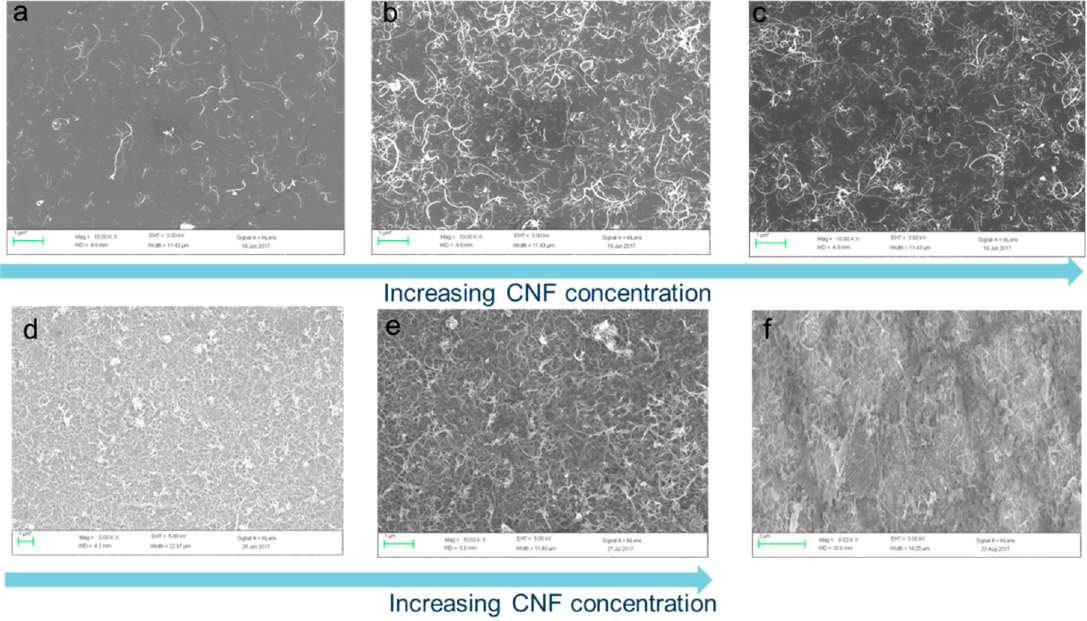
Figure 4. SEM images of carbon nanofibers (CNFs) deposited with the spray technique. The coverage rate increases until full coverage is reached in Figure 5e (single nozzle) and 5f (double nozzle). The concentration of the CNFs is increased due to the deposition time ( a ) 3 µ m − 1 ( b ) 6 µ m − 1 ( c ) 10 µ m − 1 ( d ) 15 µ m − 1 ( e ) 30 µ m − 1 ( f ) 60 µ m − 1 (the number corresponds to the CNFs, but an error of around 20% must be taken into